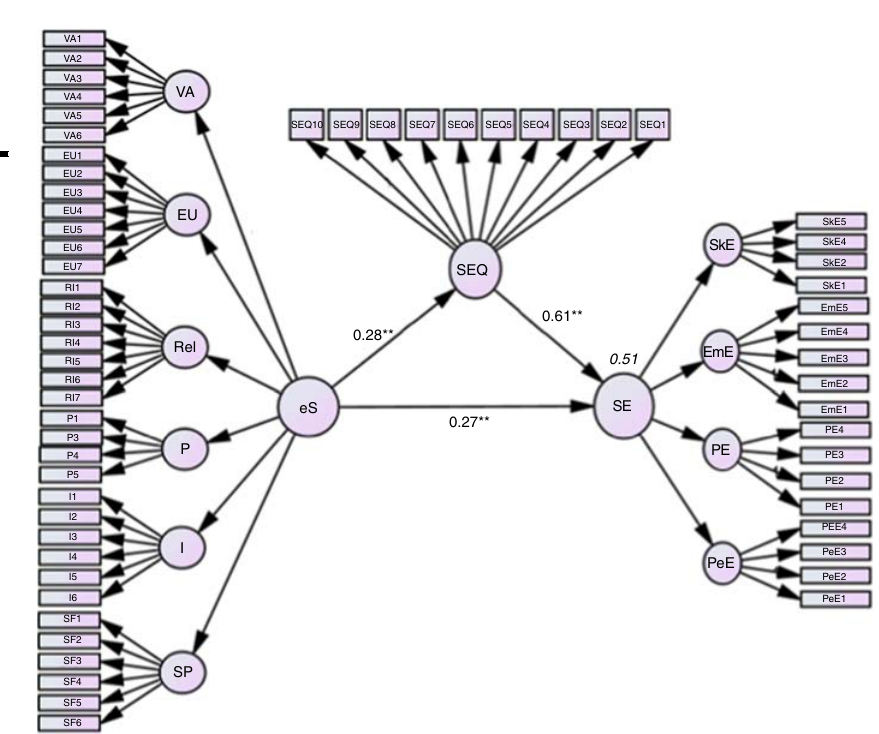
Figure A1. Structural